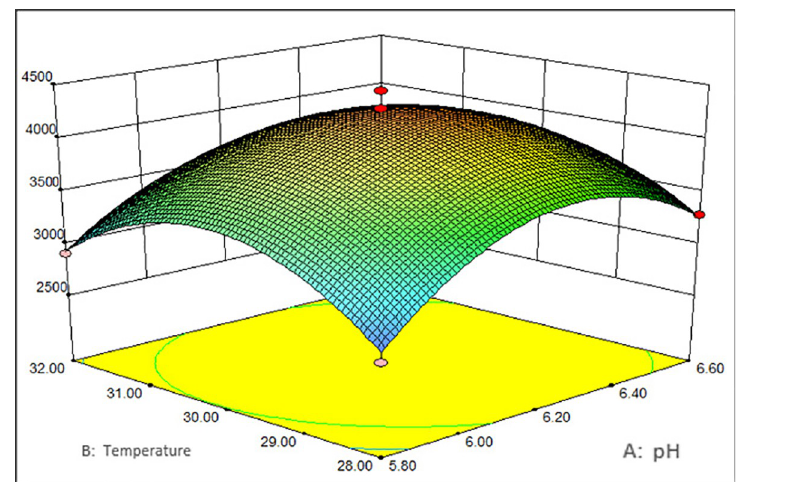
Fig 1. Interaction of temperature and pH vs. the yield of MRYP.